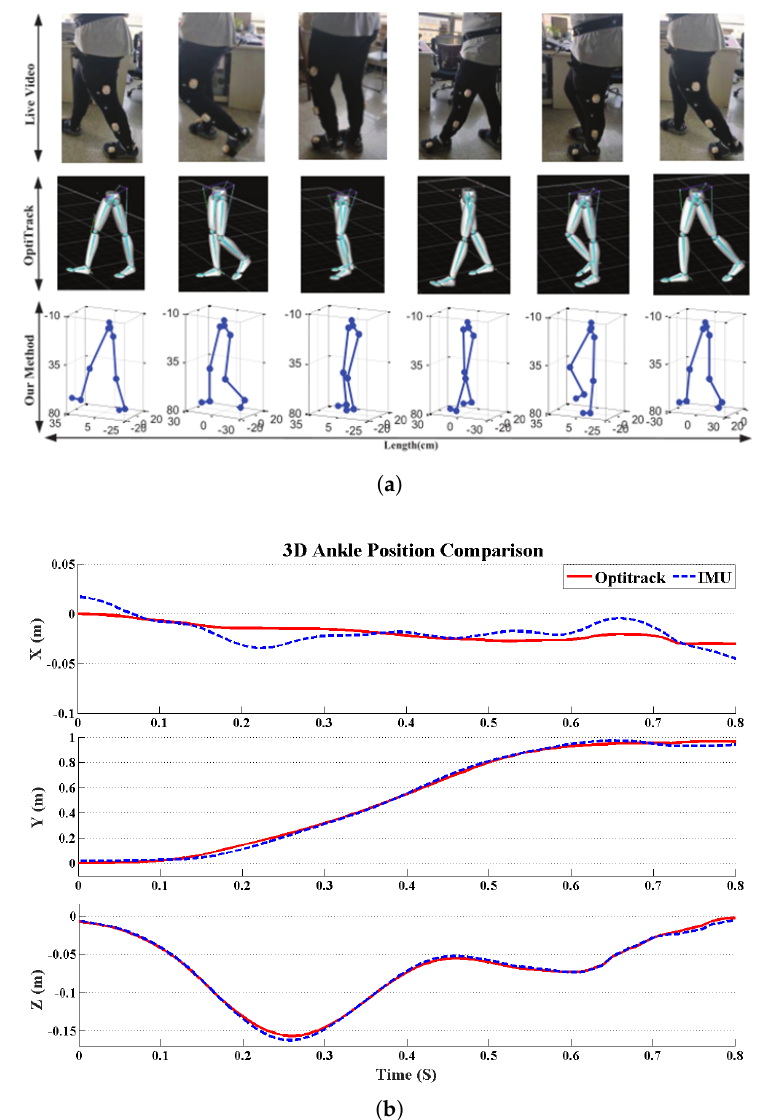
Figure 11. Results of comparative experiments using Optitrack: ( a ) Motion reconstruction; ( b ) ankle position